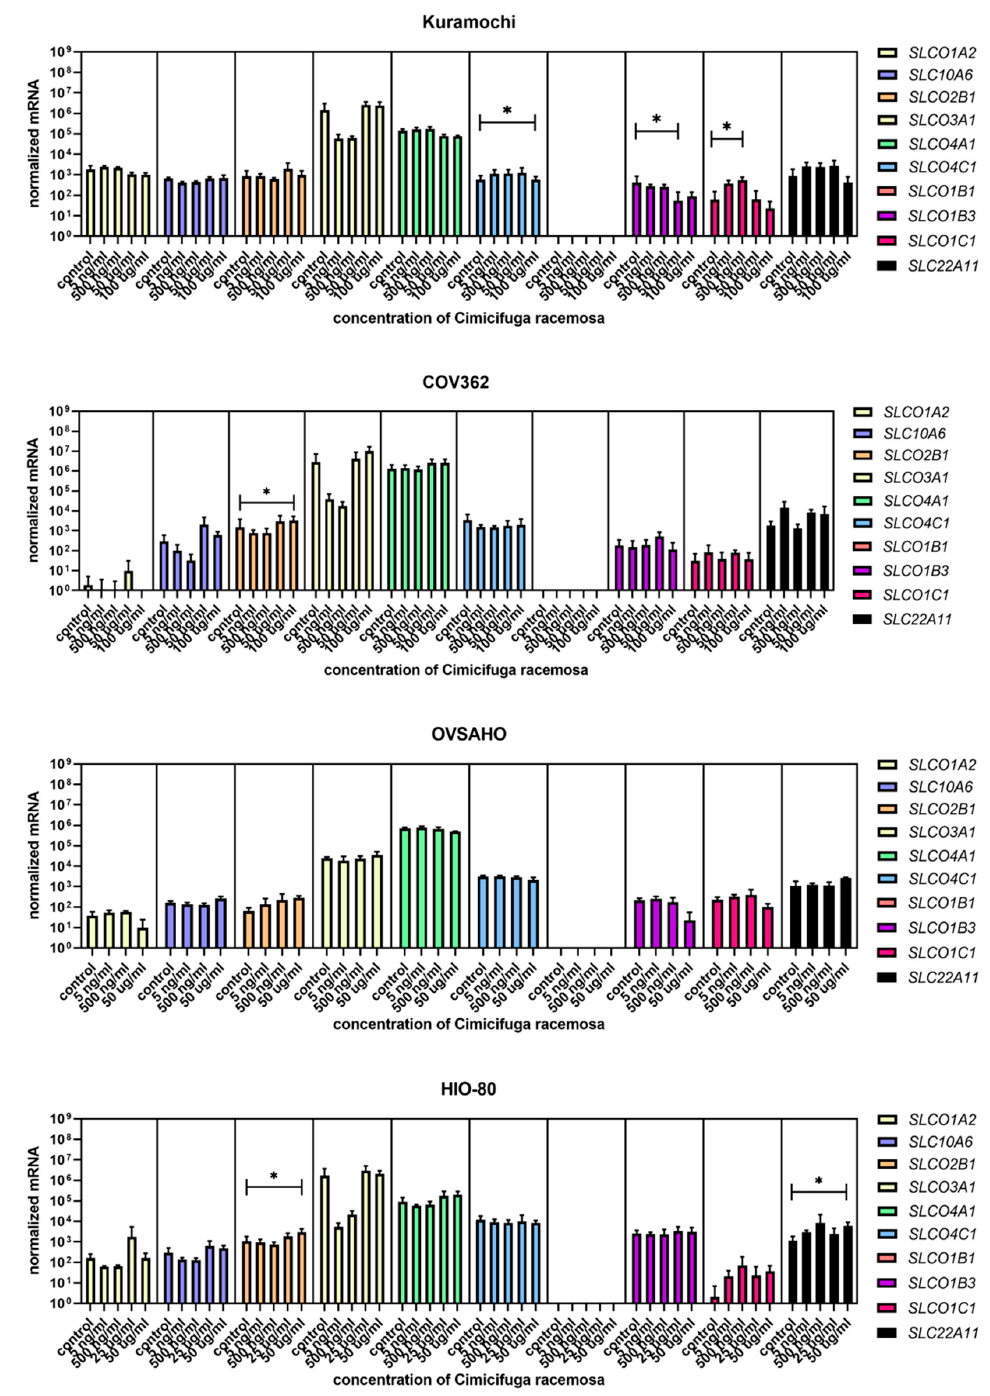
Figure 9. Normalized expression of 10 different genes of uptake ( SLC01A2 , SLC10A6 , SLCO2B1 , SLCO3A1 , SLCO4A1 , SLCO4C1 , SLCO1B1 , SLCO1B3 , SLCO1C1 , SLC22A11 ) in the ovarian cancer cell lines Kuramochi, COV362, and OVSAHO and control cell line HIO-80. At least three independent experiments were performed. Data are shown as mean ± SD. * p -value ≤ 0.05.